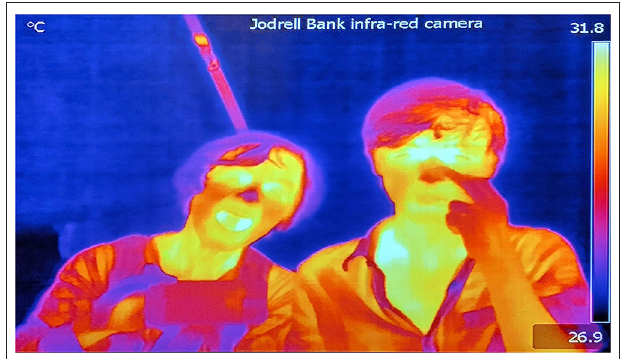
FIGURE 2 | Still from infrared camera at Jodrell Bank, Cheshire, UK.